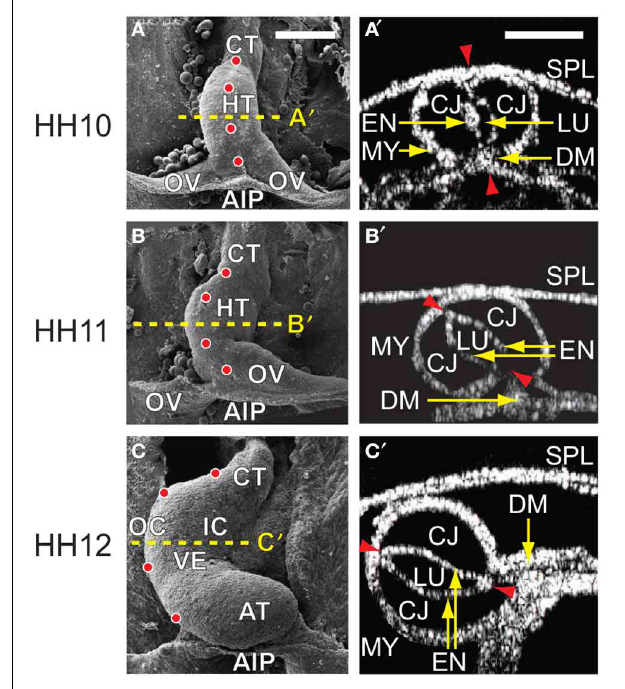
FIGURE 1 | Cardiac c-looping in chick embryo. (A–C) SEM images of embryonic chick hearts during c-looping (ventral view). (Reprinted from Shi et al., 2014 with permission of ASME.) The originally straight heart tube (HT) at HH10 in (A) bends ventrally and rotates rightward, transforming into a c-shaped tube at HH12 in (C) . Note that artificial labels (red dots) along the ventral midline of the HT at HH10 move to the outer curvature of the HH12 heart. (A (cid:2) –C (cid:2) ) Rotation of the HT is shown by the orientation of the elliptical lumen (red arrowheads) in OCT cross sections taken midway along the length of the HT [yellow dashed lines in (A–C) ]. AIP, anterior intestinal portal; AT, atrium; CJ, cardiac jelly; CT, conotruncus; DM, dorsal mesocardium; EN, endocardium; IC, inner curvature; LU, lumen; MY, myocardium; OC, outer curvature; OV, omphalomesenteric vein; SPL, splanchnopleure; VE, ventricle. Scale bars: 200 μ m. Yellow arrows indicate the annotated anatomic